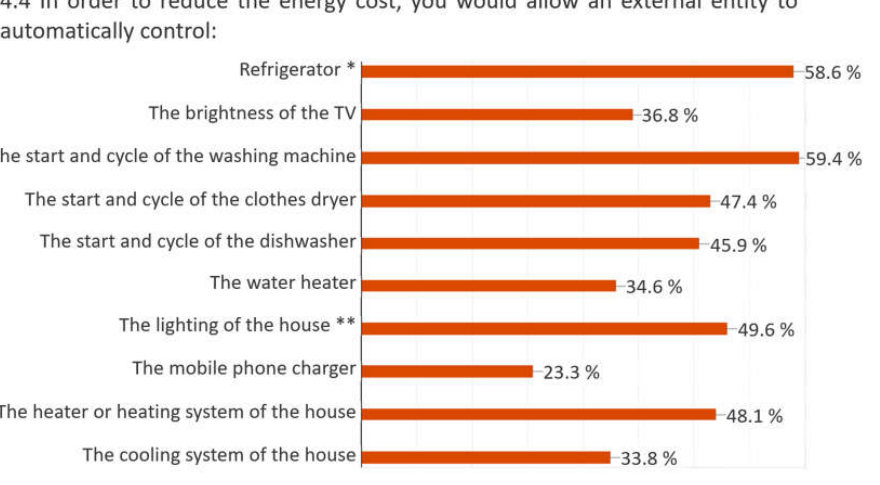
Figure 5. Replies to question 4.